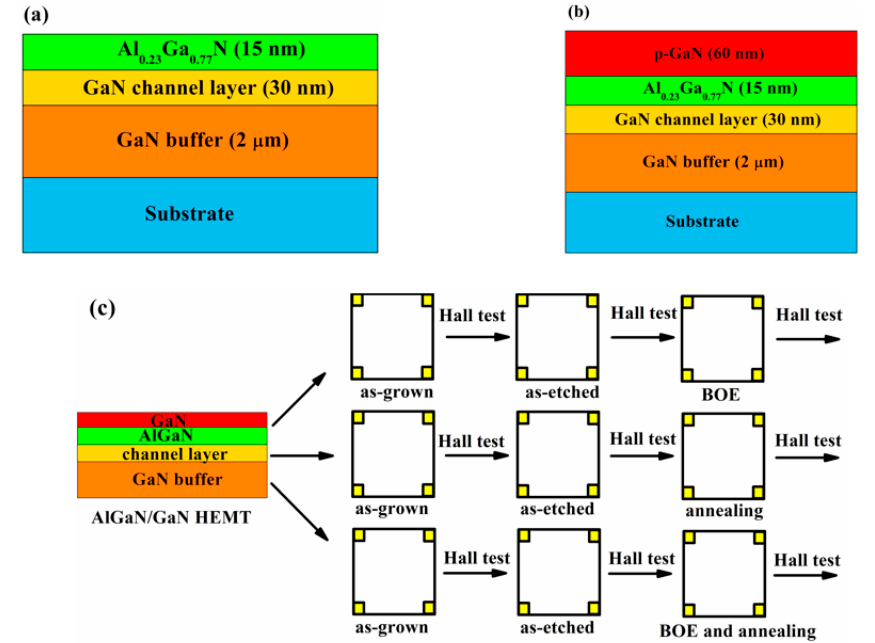
Figure 1. ( a ) Epi-structure of the AlGaN/GaN high-electron-mobility transistor (HEMT), ( b ) epi- structure of the p-GaN high-electron-mobility transistor (HEMT), and ( c ) the experimental steps of the AlGaN/GaN HEMT.